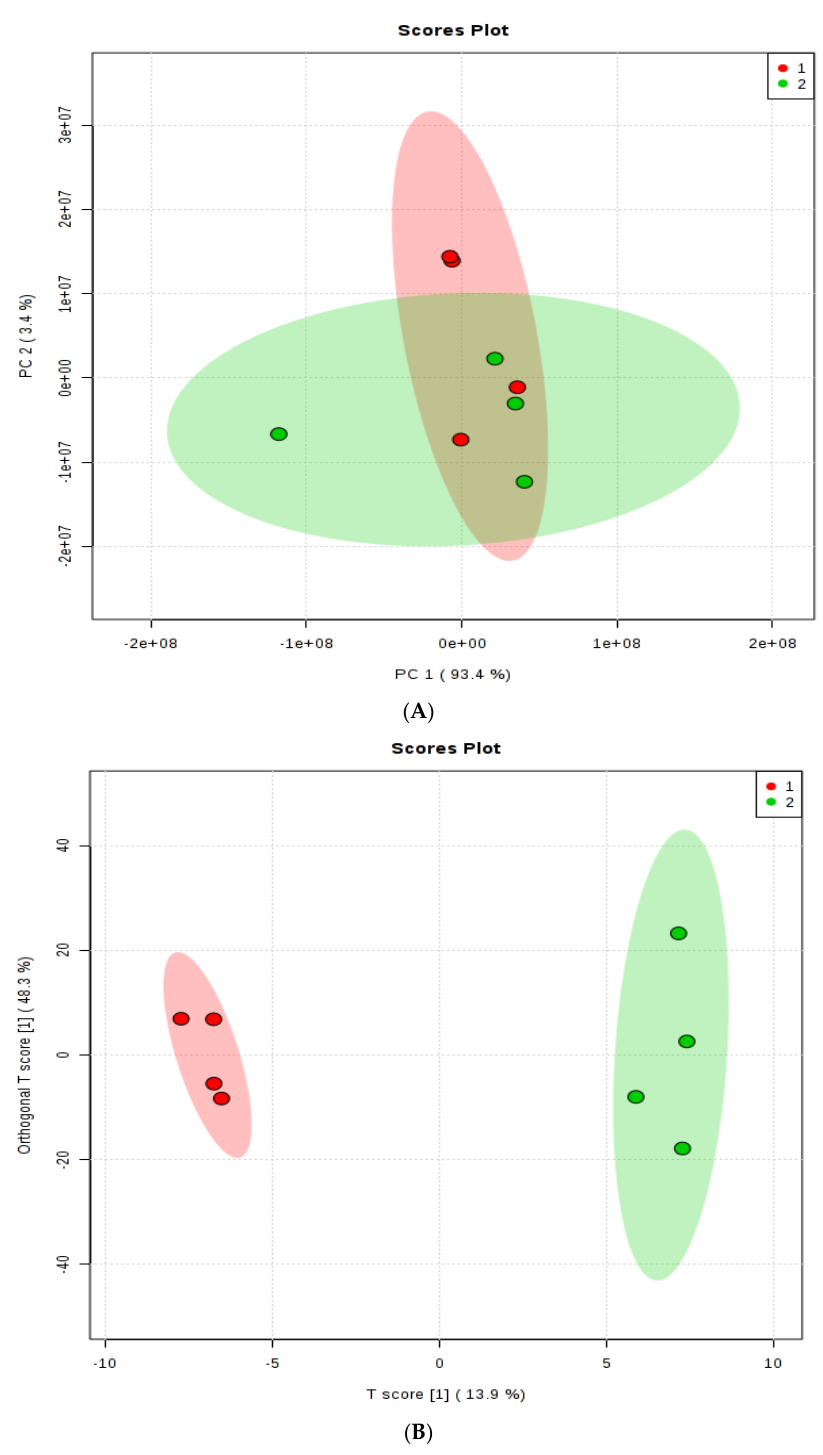
Figure 4. ( A ) The scores plot of PCA model showing the directions that best explain the variance between the two treatments. ( B ) OPLS-DA score plot of all metabolite features. Group 1 = steers fed Control diet, Group 2 = steers fed 200 mg d −1 of monensin. One data point represents one composite rumen fluid sample of each steer.